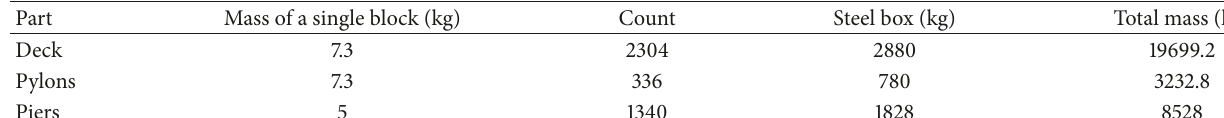
Table 2: Additional masses of different parts.